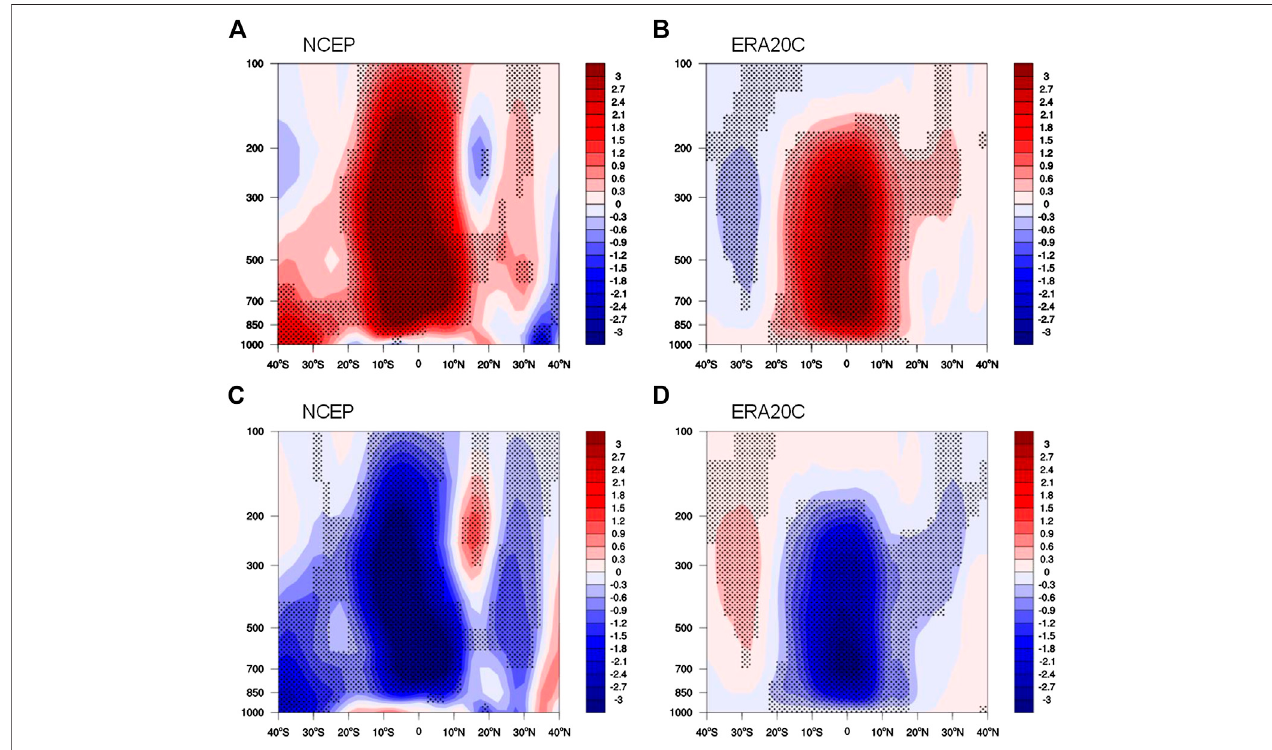
FIGURE 3 | The Hadley circulation mass stream function (10 8 kg s − 1 ) regressed on the normalized HC strength seesaw index derived from the (A) NCEP data set from 1948 to 2013, and (B) ERA20C data set from 1900 to 2010. The Hadley circulation mass stream function (10 8 kg s − 1 ) regressed on the normalized AMV index derived from the (C) NCEP data set and (D) ERA20C data set. Dotted shading indicates the regression coef fi cients signi fi cant at the 95% con fi dence level.